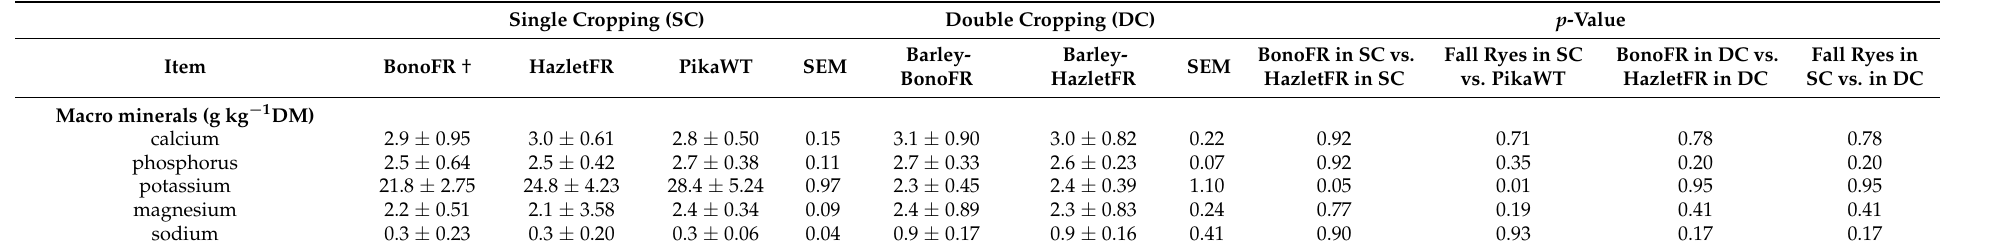
Table 6. Mineral composition (means ± SD) of winter cereals in single and double cropping systems. Single Cropping (SC) Double Cropping (DC) p